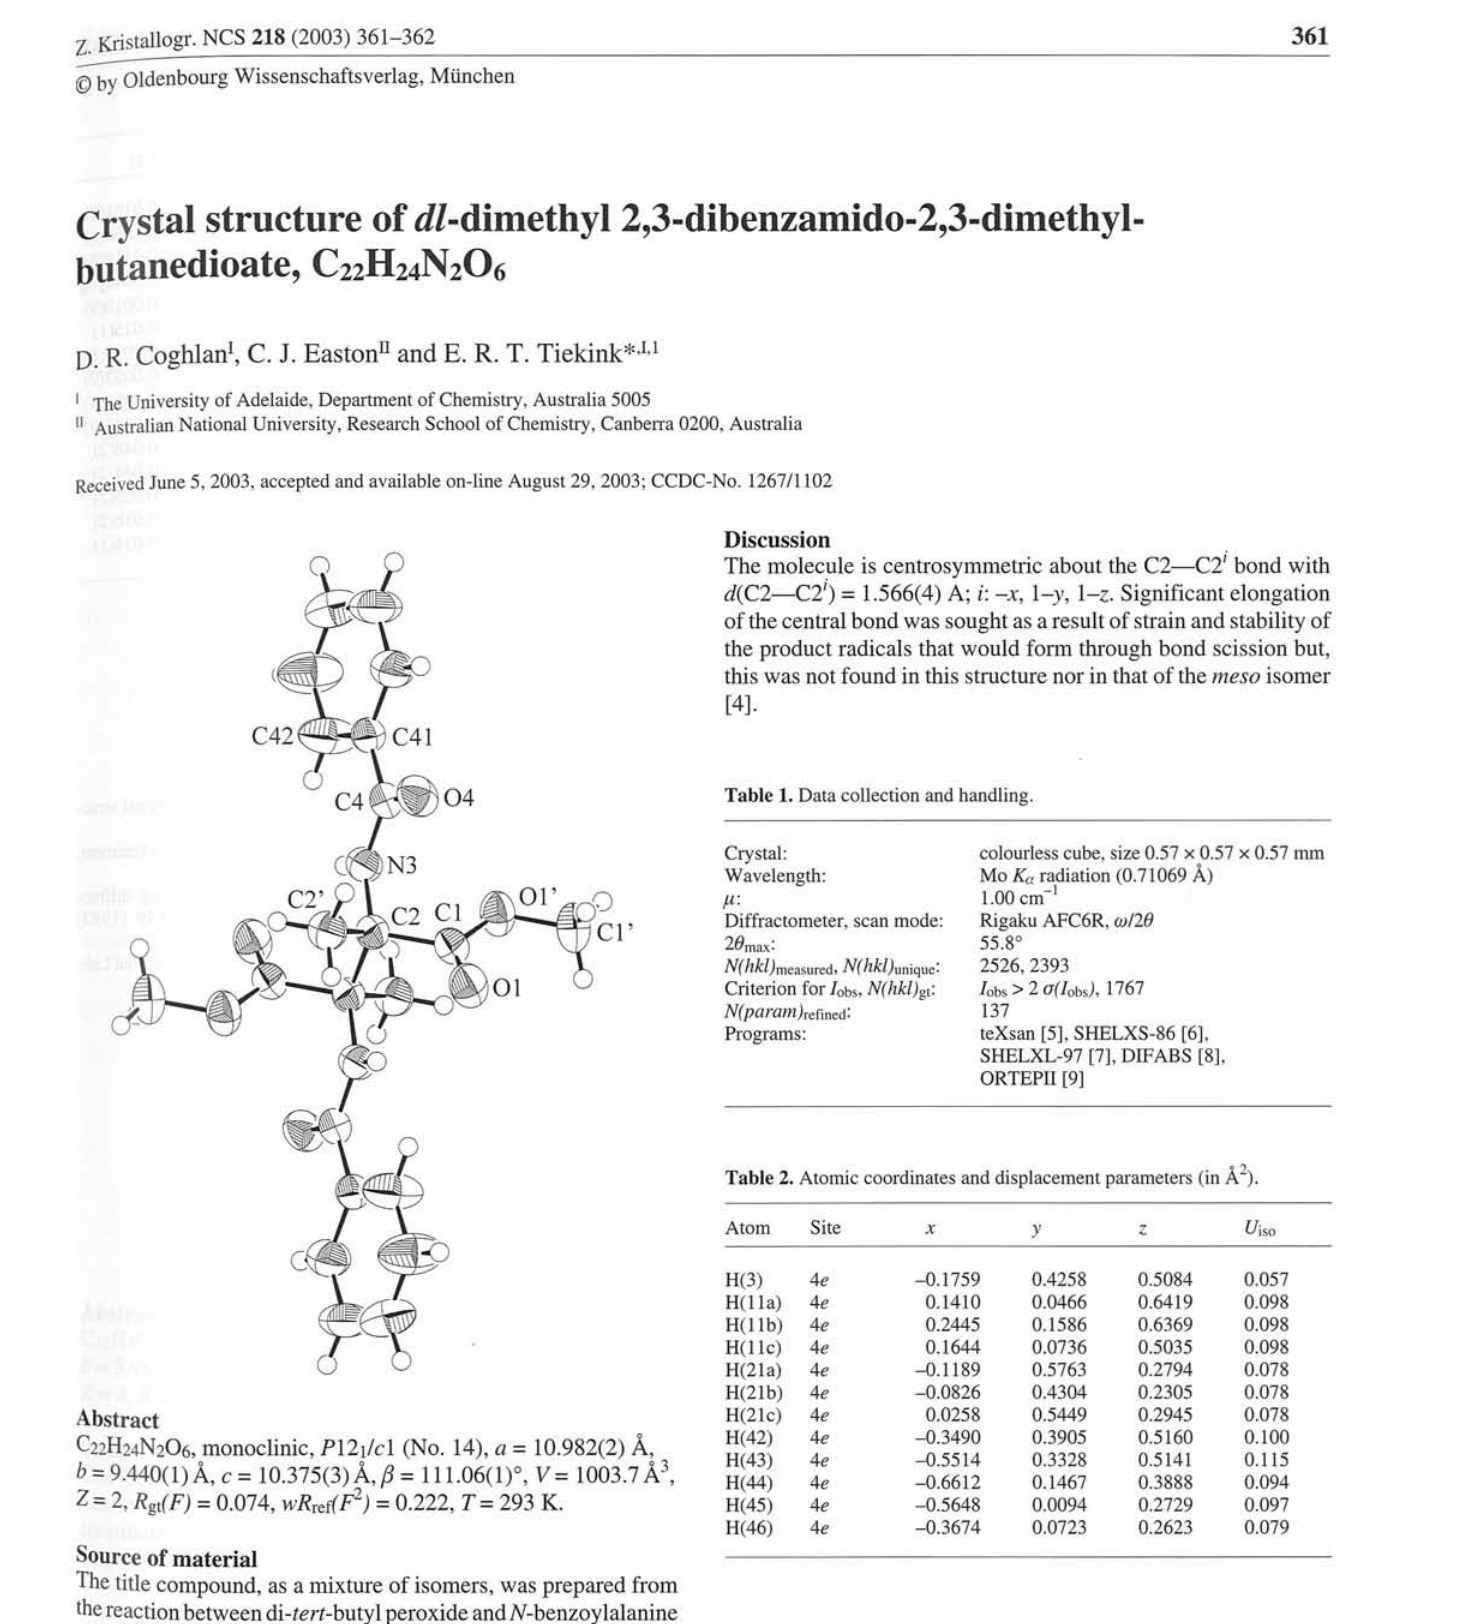
o 9 Table 2. Atomic coordinates and displacement parameters (in